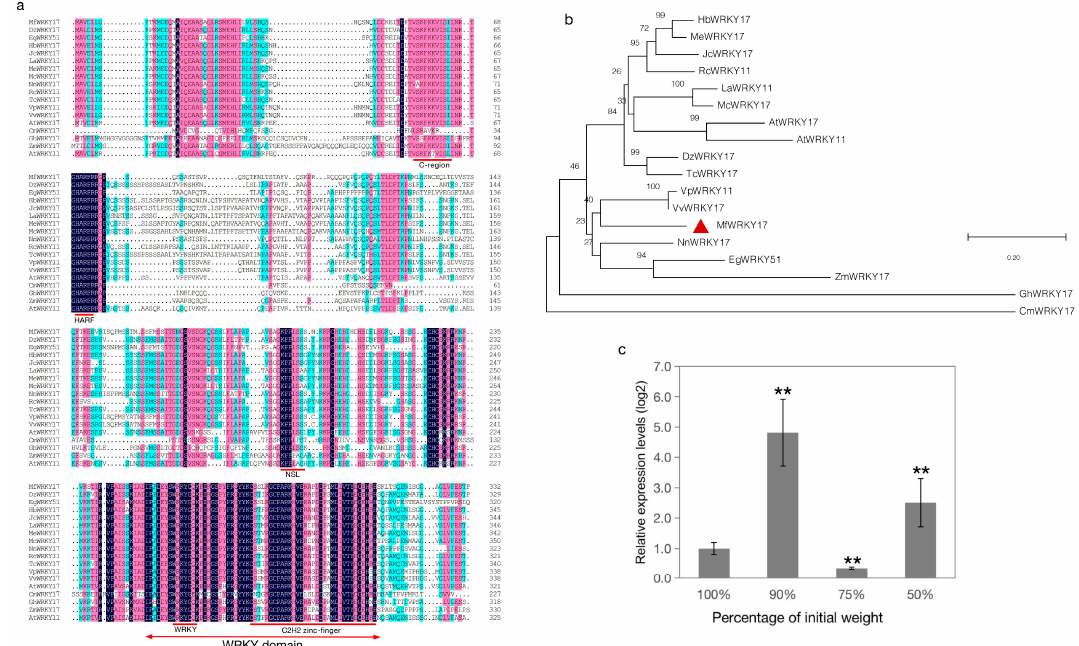
Figure 1. Sequence analysis and expression level of MfWRKY17 . ( a ) Multiple alignment of deduced amino acid sequences; ( b ) Phylogenetic tree constructed using the neighbor-joining method, with